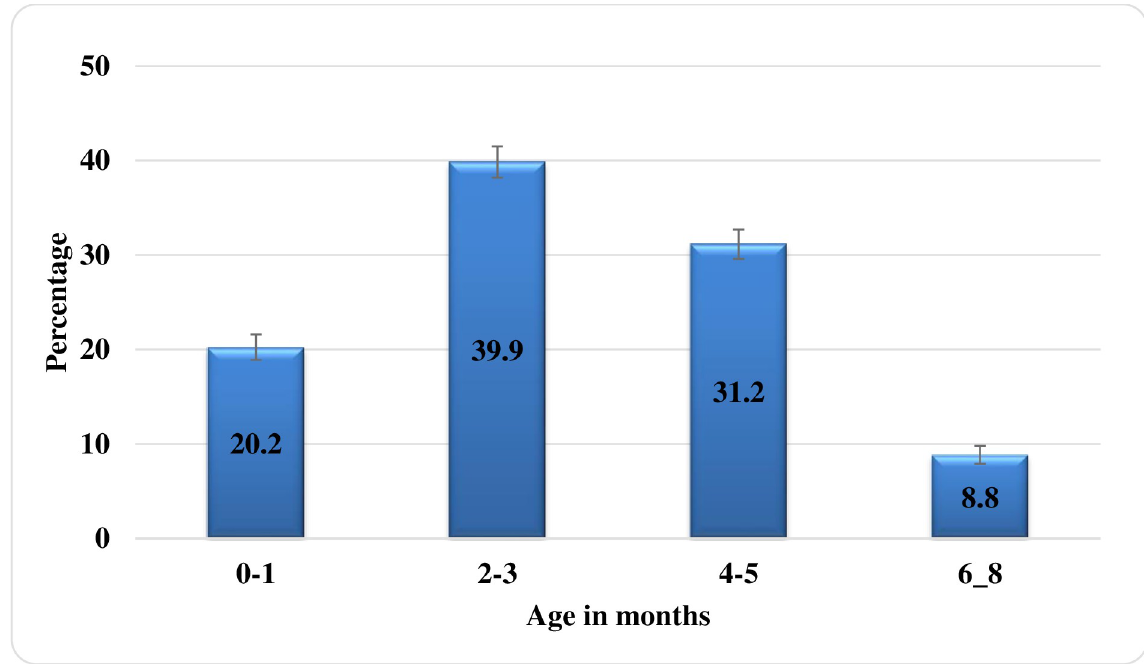
Fig 3. Distribution of children according to age at introduction of complementary